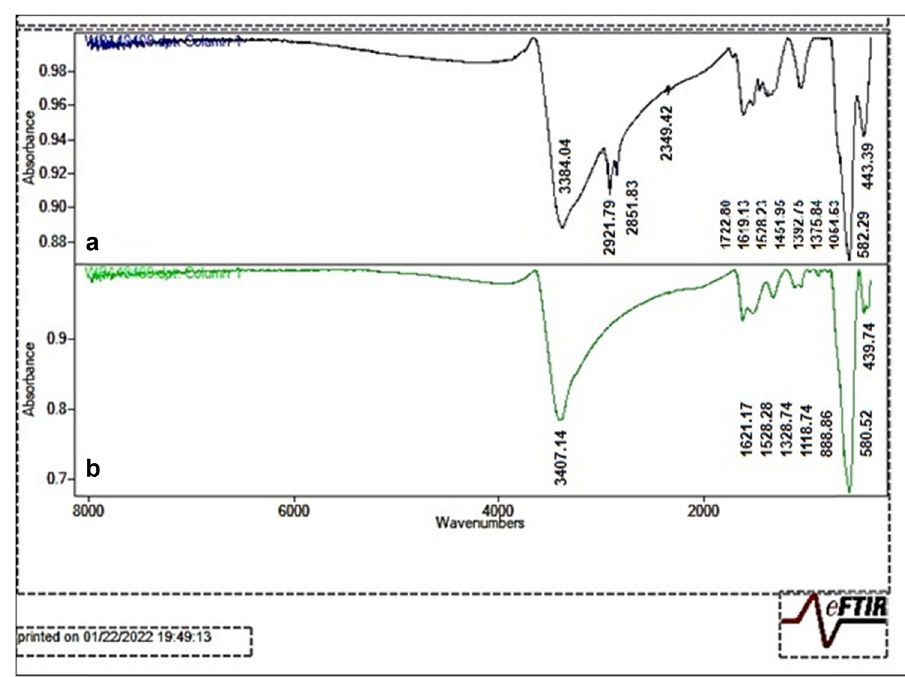
Figure 6: FTIR analysis of ( a ) green - synthesized IONPs and ( b ) standard IONPs.